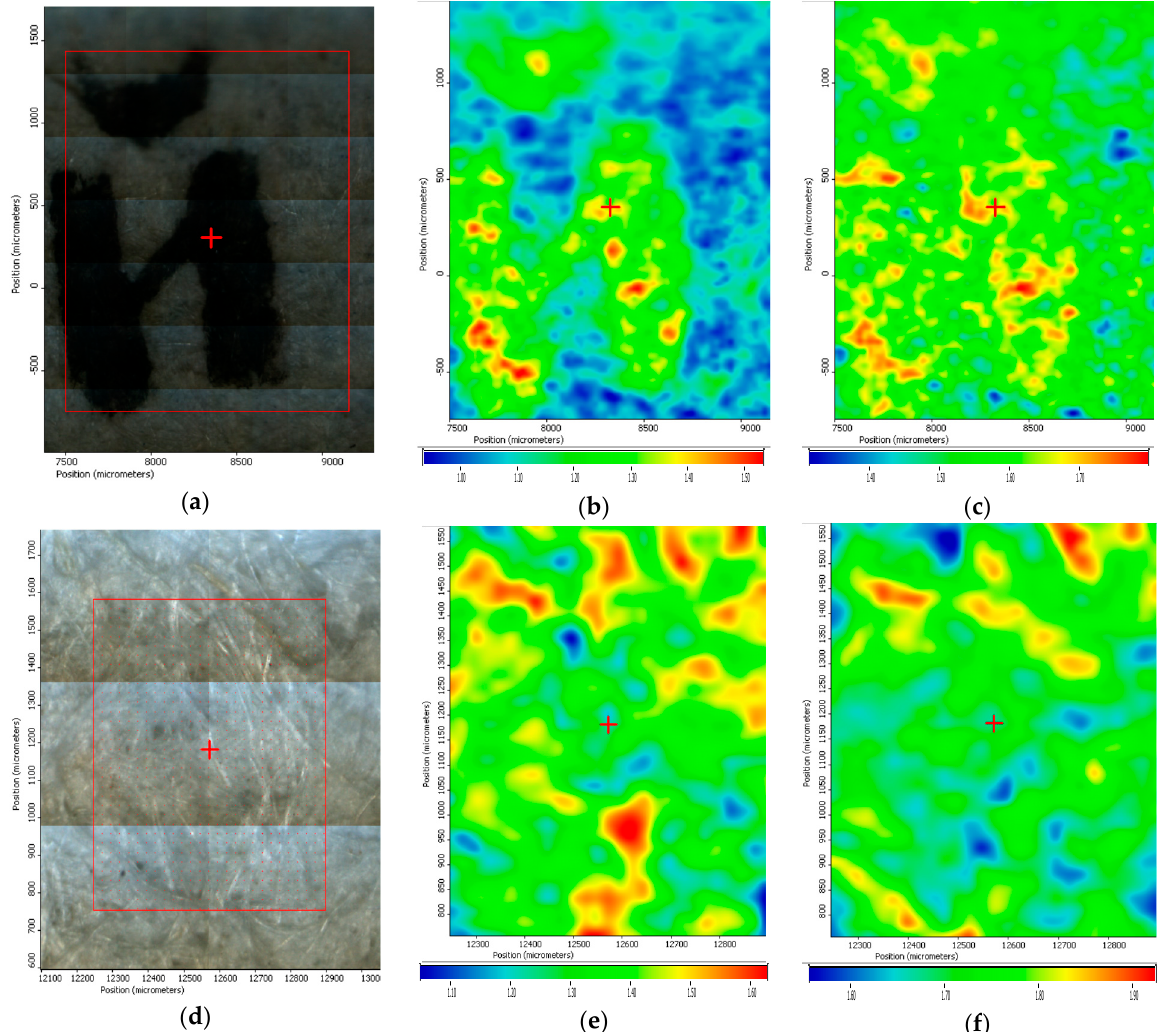
Figure 10. FTIR microscopy on sample A_ZnO ( a – c ) and sample B_ZnO ( d – f ): video image of paper ( a , d ); FTIR map at 1643 cm − 1 ( b , e ); FTIR map at 430 cm − 1 ( c , f ).